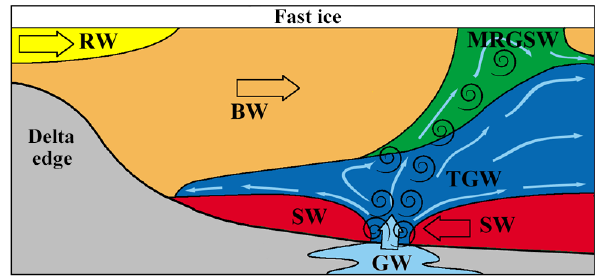
Figure 13. The scheme of water masses mixing near the SGD lo- cation. The large black arrows show the direction of end-member movement, small light blue arrows show the direction of GW flow movement, and black spirals show